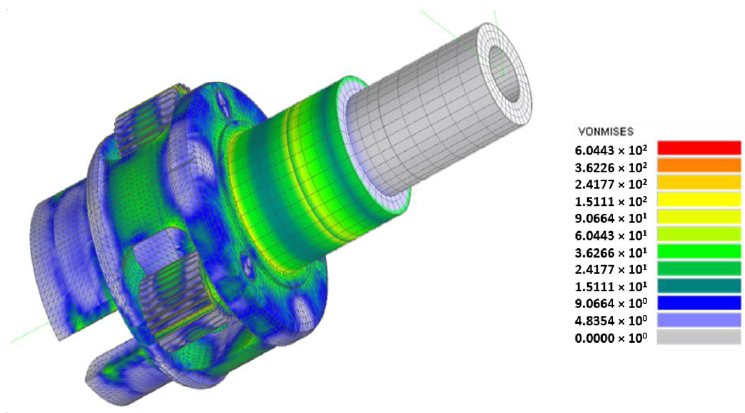
Figure 5. FE results (housing removed due to visibility reasons).